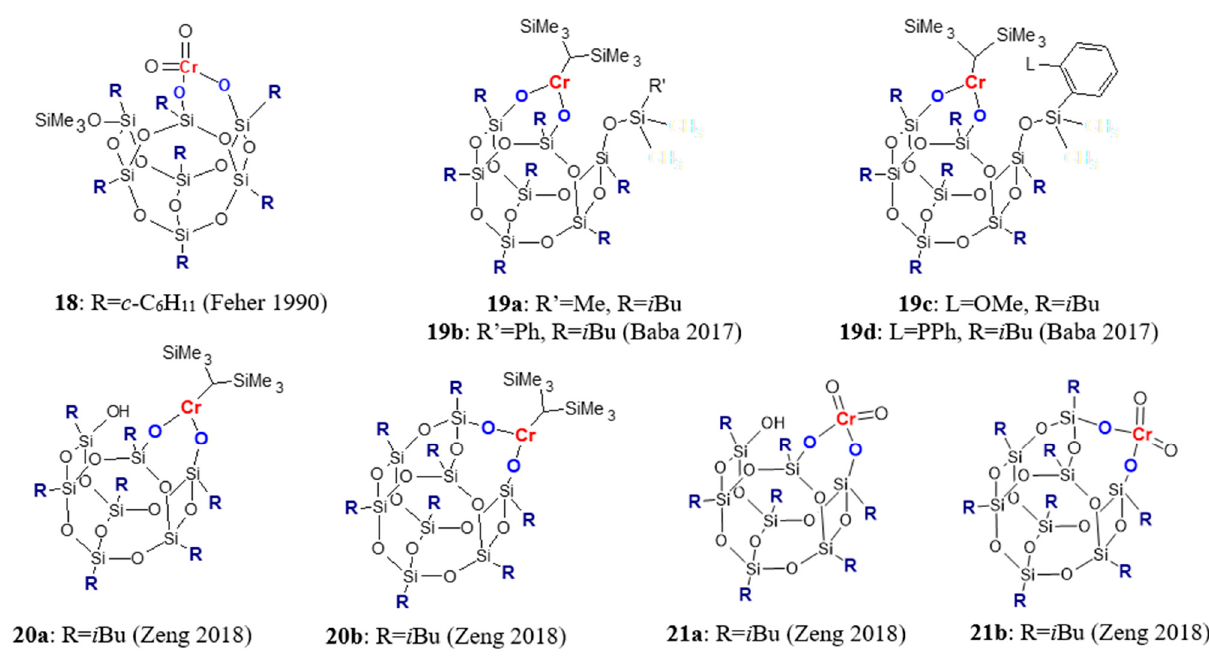
Figure 4. Silsesquioxane complexes of chromium used in olefin polymerization